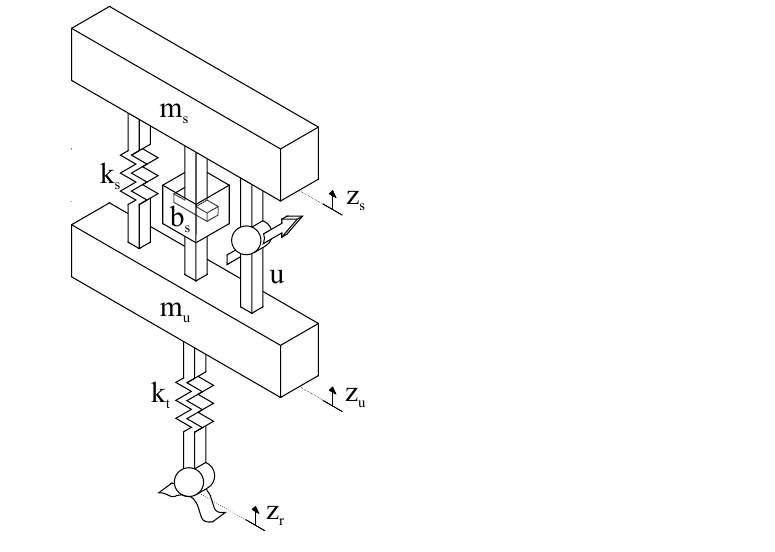
Figure 6. Quarter vehicle model of active suspension